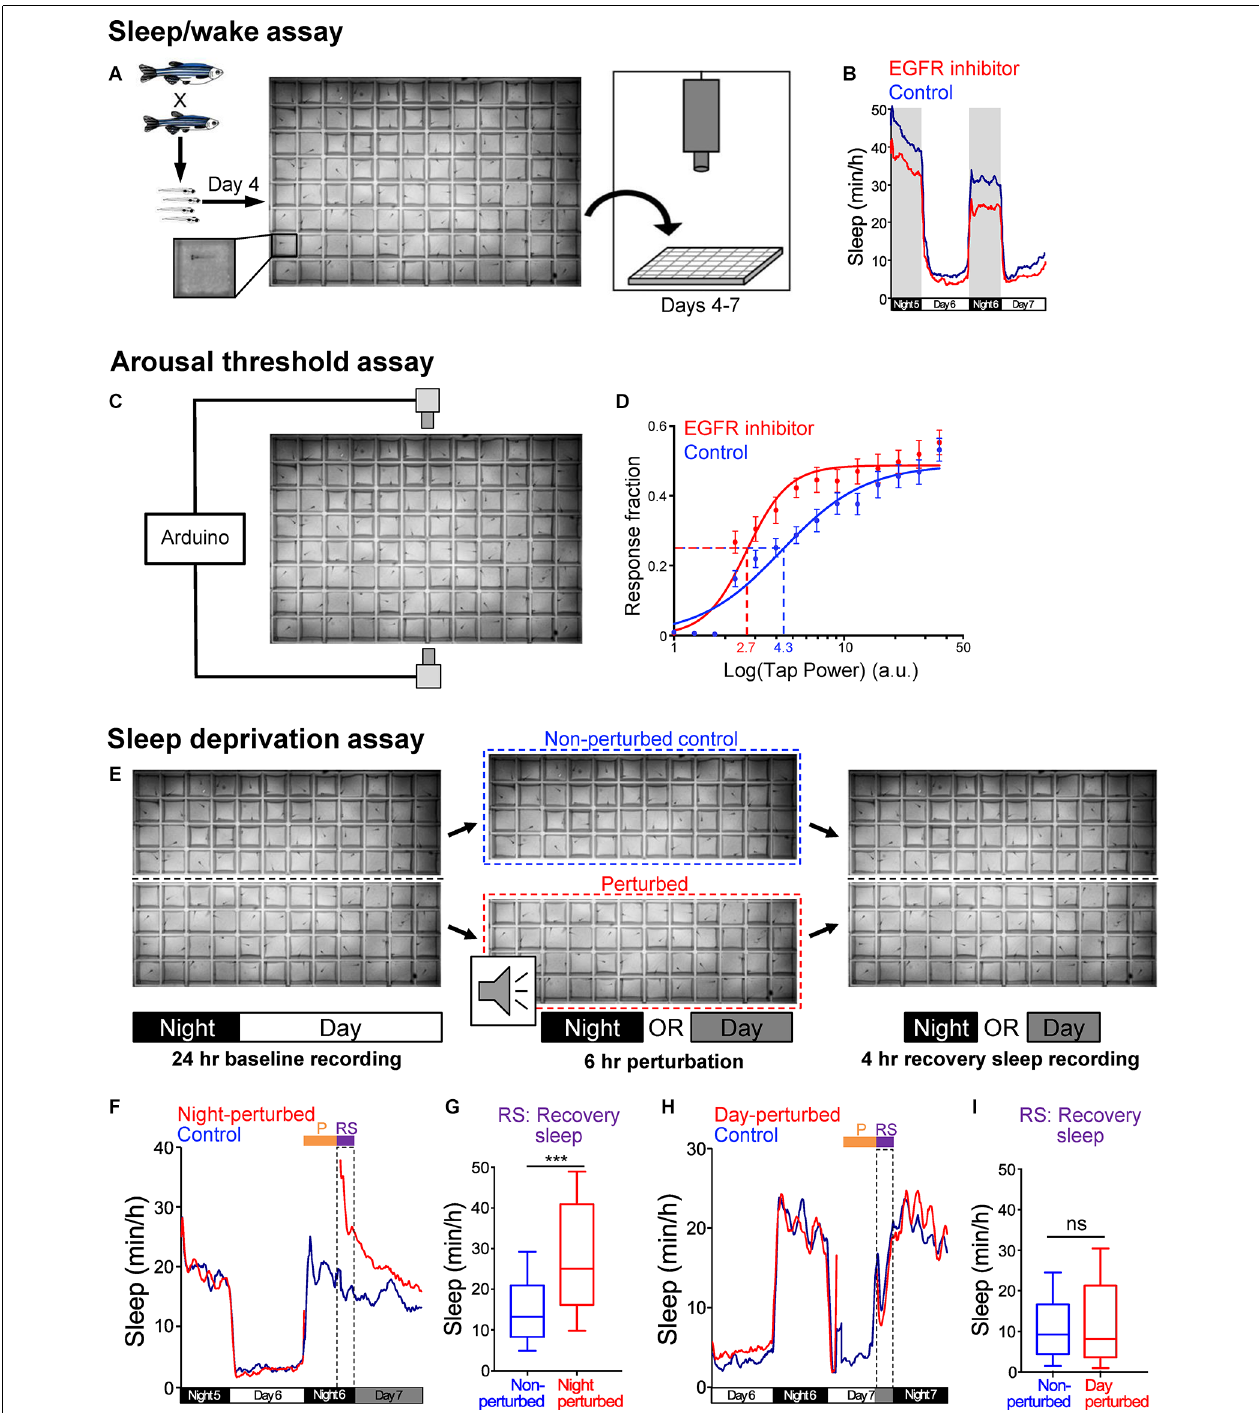
FIGURE 2 | Zebrafish sleep assays. (A) Schematic of sleep assay. Larval zebrafish at 4-dpf obtained from an in-cross of heterozygous mutant fish are individually placed in each well of a 96-well plate that is filled with E3 medium and is maintained at 28.5 ◦ C by recirculating heated water. The plate is placed in a videotracking system, and is illuminated from below with white light from 9 a.m. to 11 p.m. and continuously with infrared light. The behavior of each fish is monitored by an infrared camera for up to 72 h. Animals are genotyped by PCR after the behavioral experiment is complete. (B) Example of data generated using the sleep assay. Zebrafish are diurnal, and thus sleep more at night compared to the day. Treatment of WT larval zebrafish with an EGFR small molecule inhibitor results in reduced sleep during both the night and day compared to siblings treated with DMSO vehicle control. (C) Schematic of arousal threshold assay. The videotracking system shown in (A) is modified by adding an Arduino board to control two solenoids that deliver a mechano-acoustic tapping stimulus to the 96-well plate during the night.